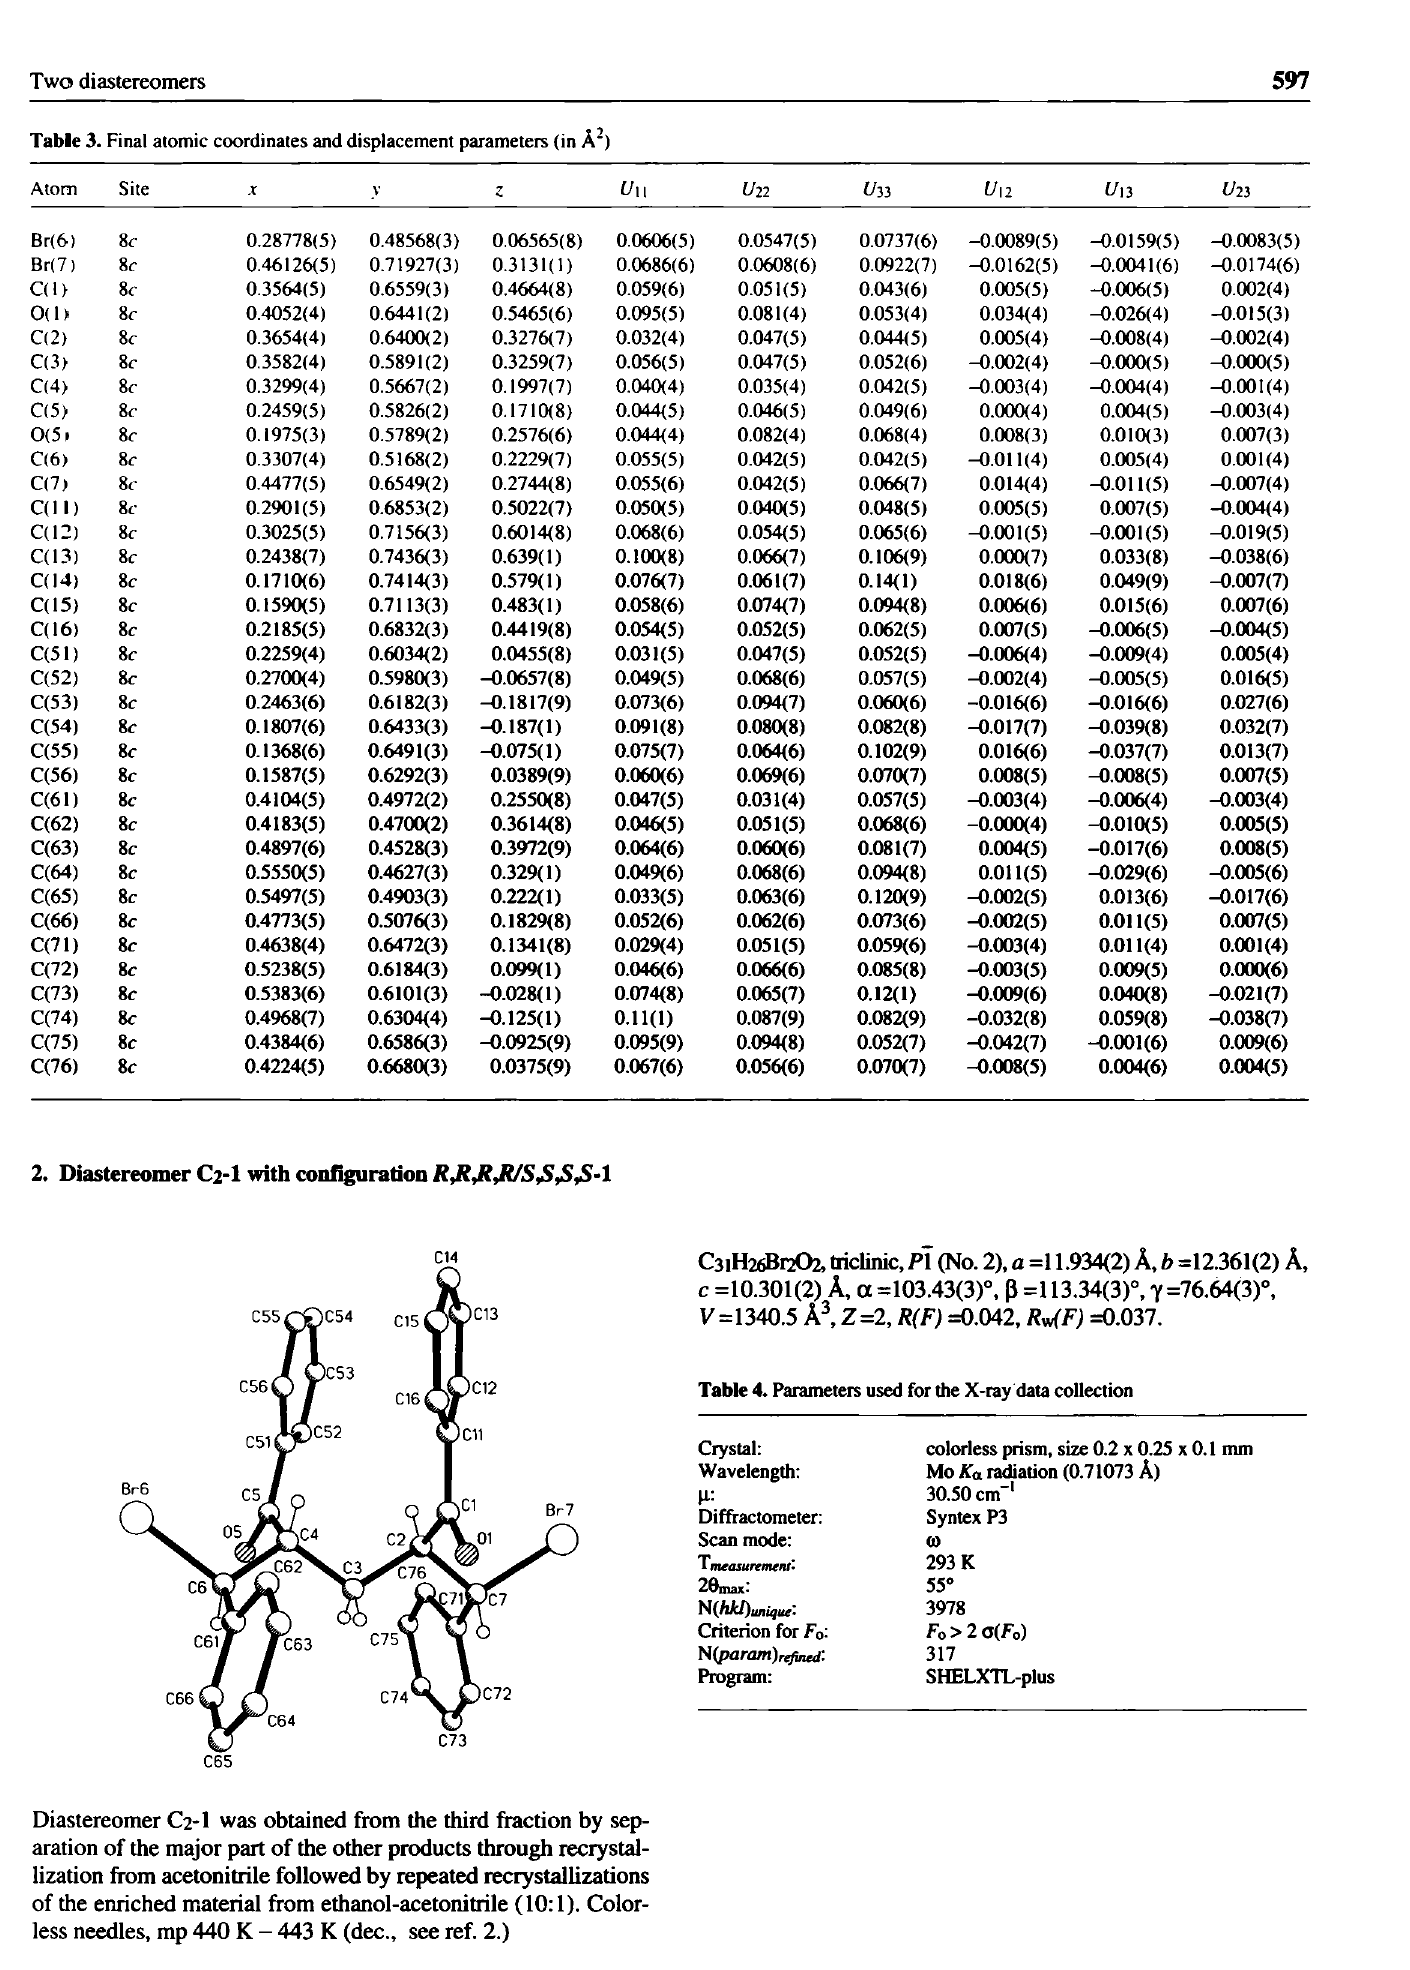
Table 3. Final atomic coordinates and displacement parameters (in Â")